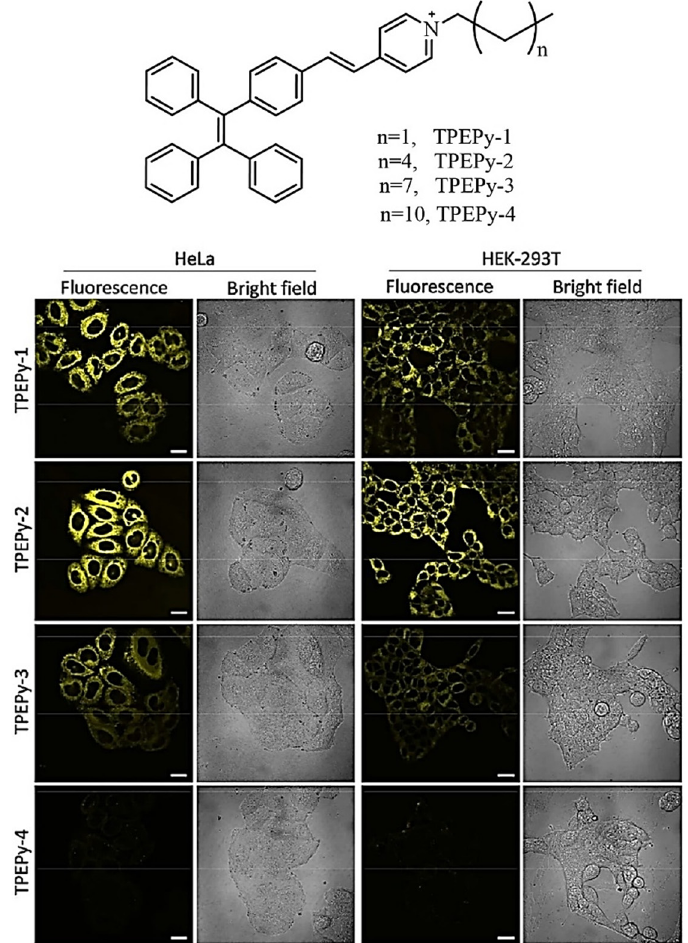
Figure 18. Structural illustration of molecule and CLSM images captured for HeLa cells and HEK- 293T cells upon incubation with (TPEPy-1, TPEPy-2, TPEPy-3, TPEPy-4) fluorogens. Reprinted from reference [95] with the permission of the American Chemical Society.